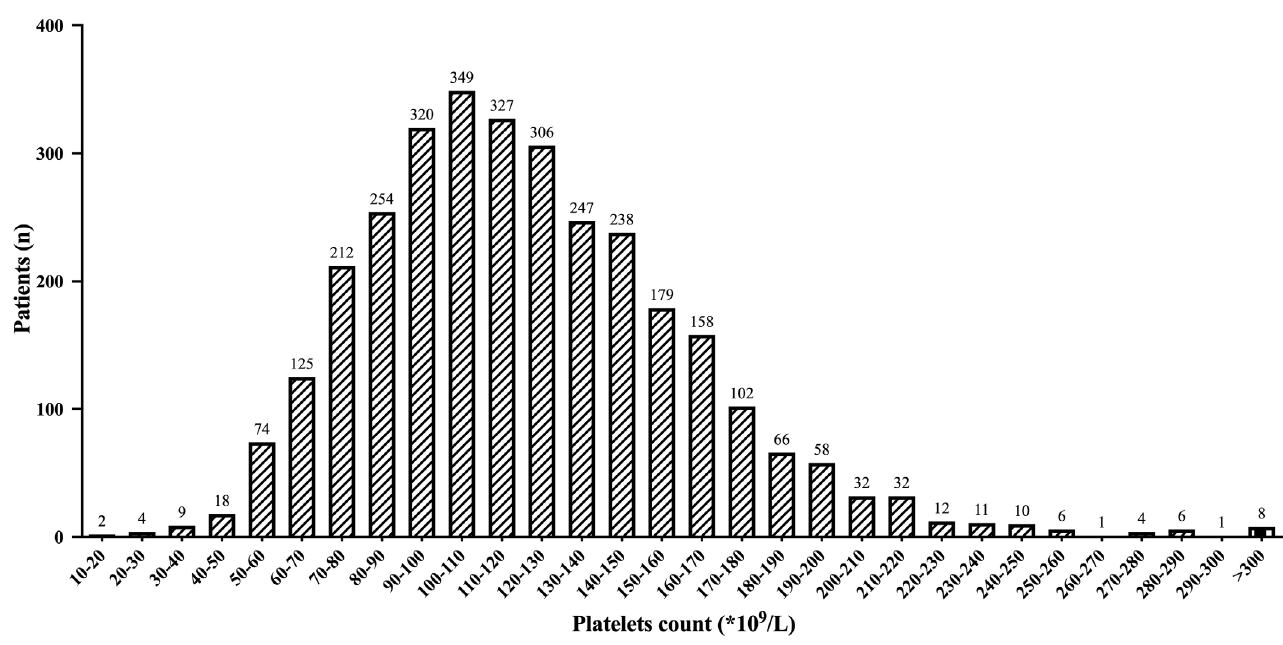
Fig. 2 - Distribution of postoperative platelet